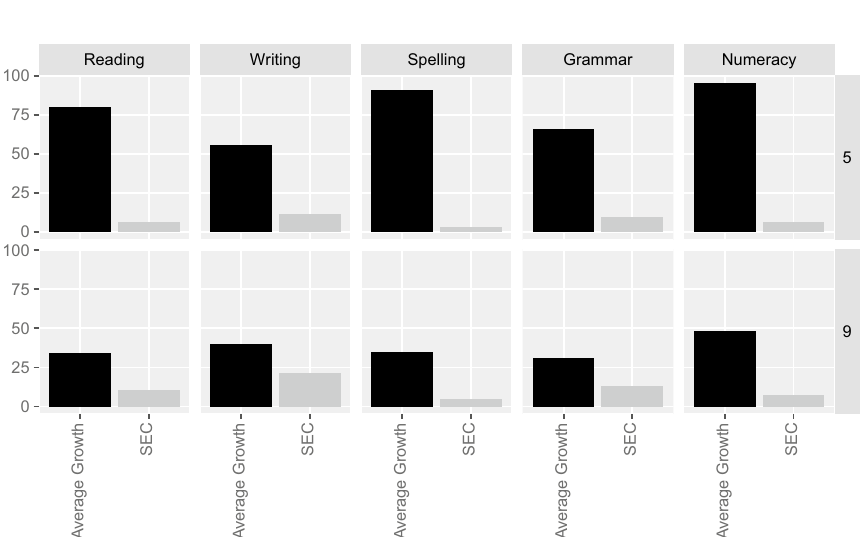
Fig. 6 Unstandardised average achievement growth and SEC effect sizes (indirect